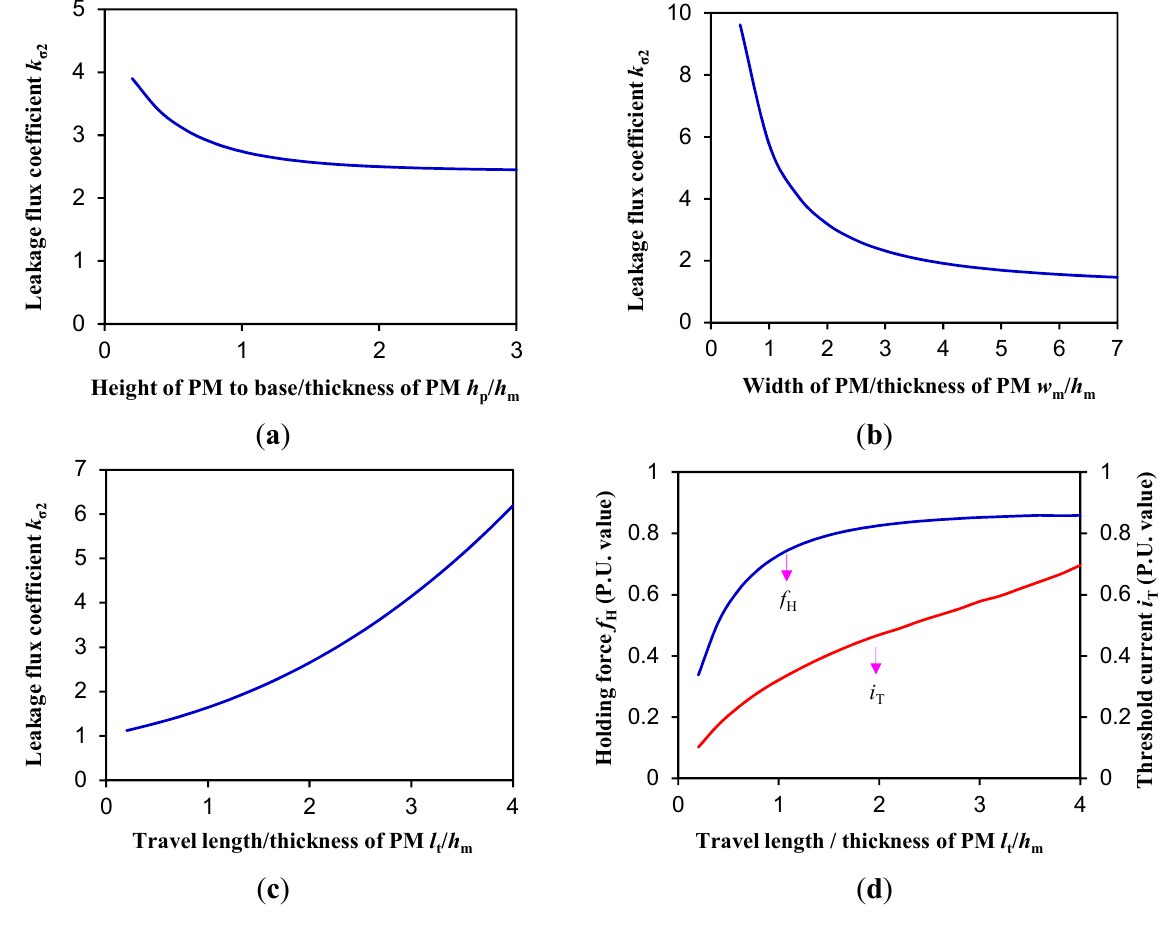
Figure 5. Opimization. ( a ) Height from PM to base; ( b ) Width of PM; ( c ) Travel length; ( d ) Travel